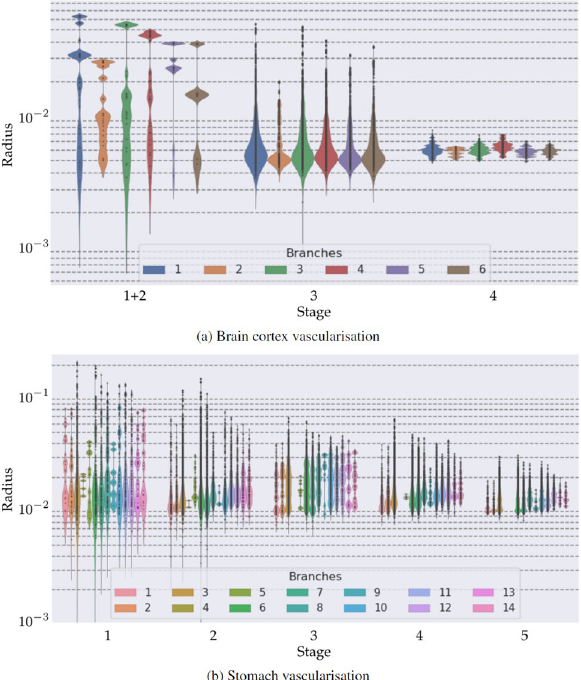
Figure 9. Radius distribution of vessels generated at each stage. Each colour corresponds to a different vessel branched form the initial tree T 0 . Black dots in the violin indicate a sample value for the radius. First stages present a multimodal distribution in which larger radius modes correspond to vessels transporting blood to neighbour regions vascularised at another stage and smaller radius modes correspond to terminal and distribution vessels. Plots generated with Seaborn library version 0.11 available at https ://seabo rn.pydat